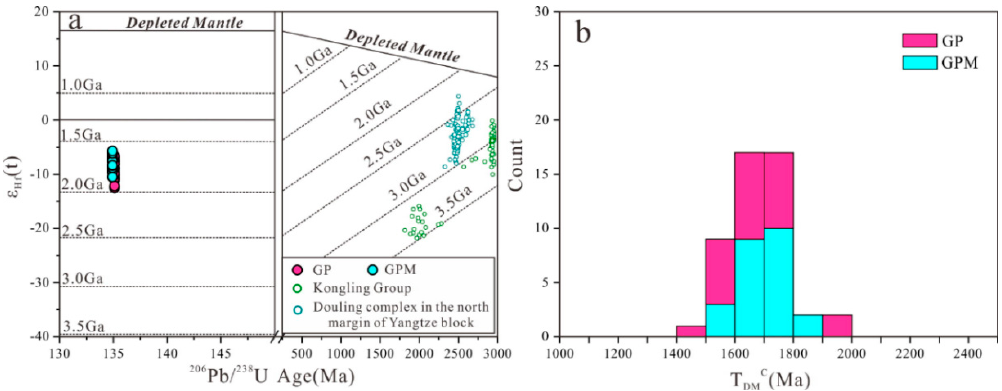
Figure 10. ( a ) Zircon Lu–Hf isotopic compositions and ( b ) T DM 2 model ages of the Qiaomaishan intrusions. Data for the Kongling Group are from [42]. Data for the Douling complex are from [43].